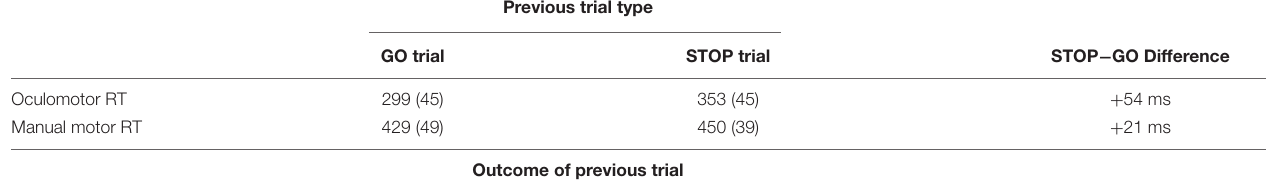
[ Table 3 ; hand: F (1,28) = 5.63, p = 0.03; eye: F (1,28) = 79.49, p < 0.001], and this difference was greater for oculomotor compared to manual responses [ Figure 5 ; Effector × Previous Trial Type interaction: F (1,28) = 5.28, p = 0.03]. During the manual task, reaction times following STOP [ r (27) = 0.81,